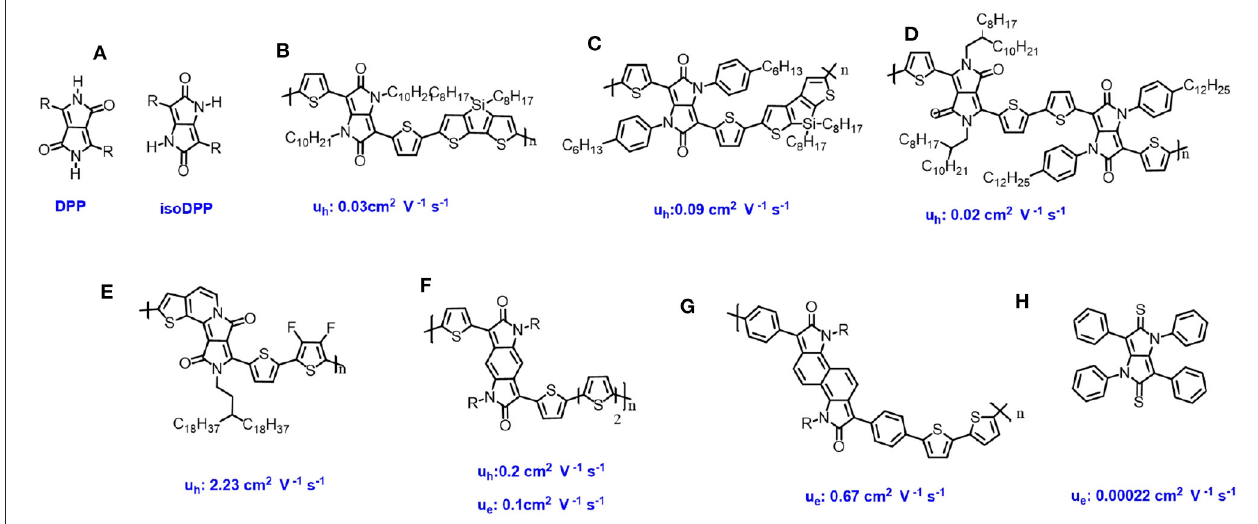
FIGURE 2 | Chemical structures of isoDPP- and DPP based derivatives for OFET and their charge transfer